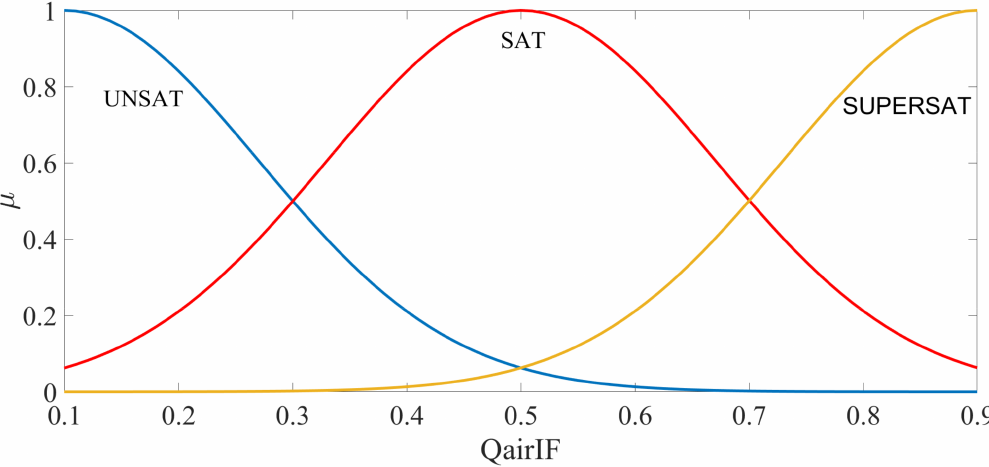
Figure 9. QairIF linguistic values (Unsaturated, Saturated, and Supersaturated) and their respective membership functions, adjusted by